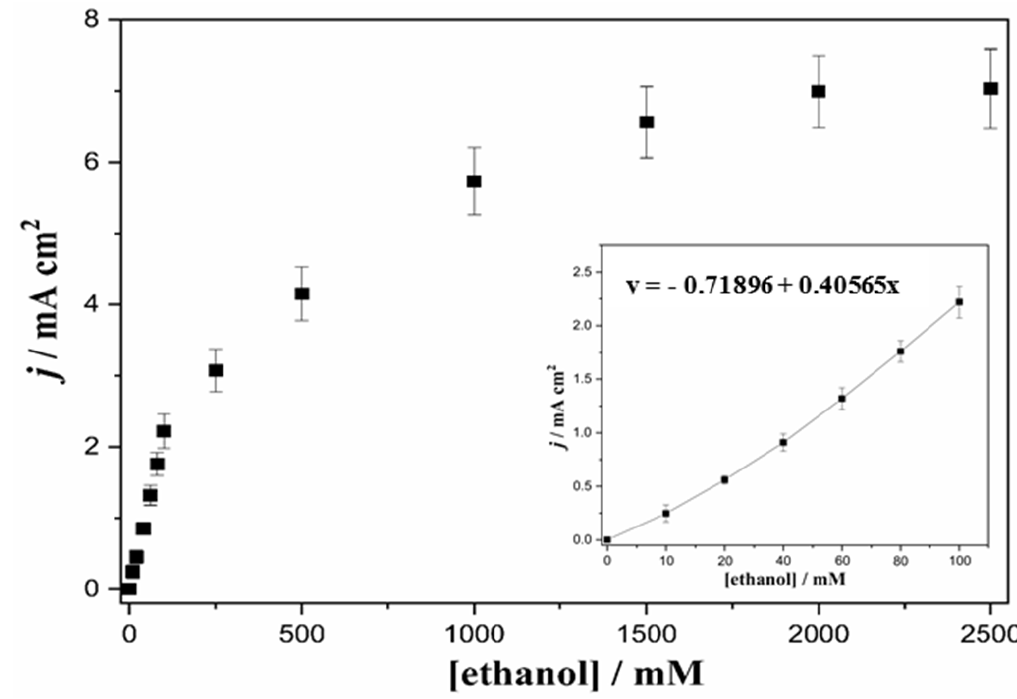
Figure 5. Calibration curve for increasing ethanol concentrations for the MWCNT-COOH/pyrene-TEMPO/OxDc electrode in 150 mM citric acid-phosphate buffer at pH = 5.2 and 25 °C: the error bars represent one standard deviation from the mean, n = 3.